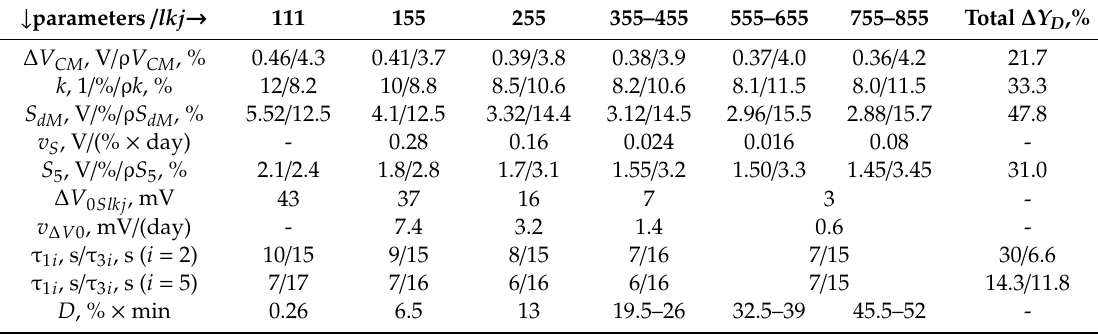
Table A2. Average values of response and model parameters of the conversion function ∆ V C ( C ) for lkj